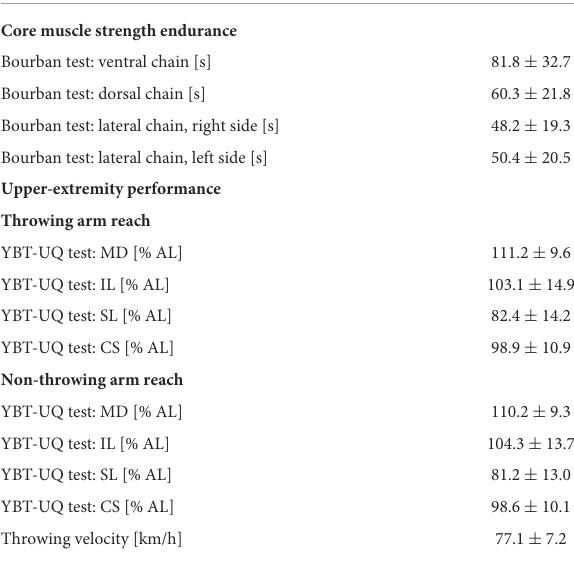
TABLE 2 Descriptive statistics for measures of core muscle strength endurance and upper-extremity performance. Test